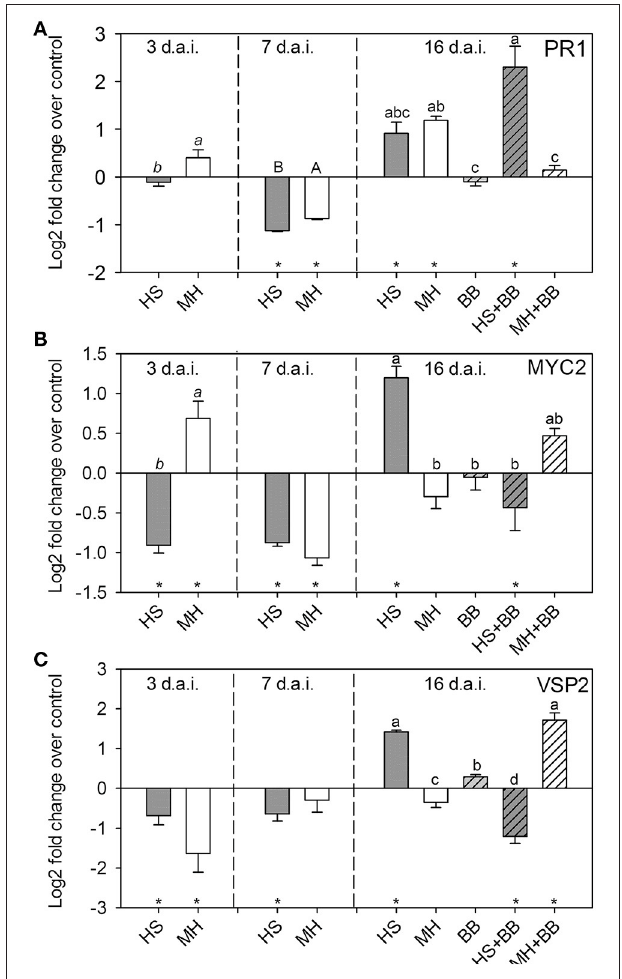
FIGURE 4 | Relative expression level (Log2) of (A) PR1 , (B) MYC2 , and (C) VSP2 in Brassica nigra at 3, 7, and 16 days after infestation (d.a.i.) with either Heterodera schachtii (HS) or Meloidogyne hapla (MH) nematodes. At 7 d.a.i., a subset of the plants was infested with Brevicoryne brassicae (BB) aphids—the plants with BB harvested at 16 d.a.i. suffered 9 days of aphid feeding. The expression levels were calculated over the average expression levels in control plants (mock inoculated with water) taken at each time point. Stars on the X-axis indicate whether the treatment significantly up –or downregulated the gene (Log2 value larger or smaller than zero; Single sample t -test, p < 0.005 to correct for multiple comparisons). N = 5 biological replicates per treatment group. Different letters over bars indicate significant differences (3 and 7 d.a.i.: t -tests; 16 d.a.i.; PR1 : multiple comparisons test after Krusall-Wallis ANOVA; MYC2 and VSP2 : Tukey HSD test after ANOVA) among treatments within harvest time